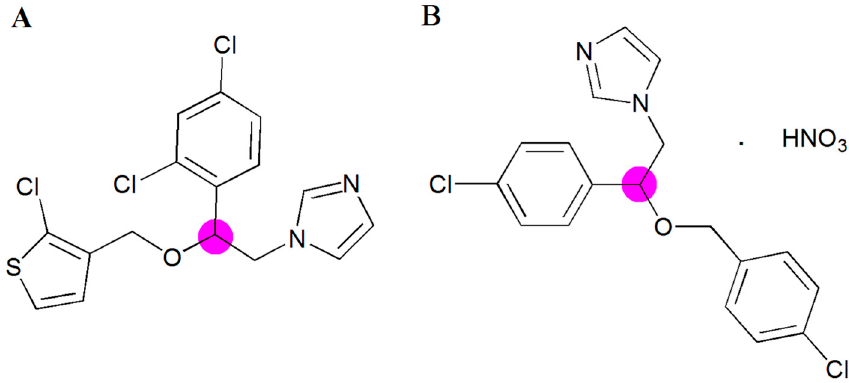
Figure 1. Chemical structure of Tioconazole ( A ) and Econazole nitrate ( B ). ● Chiral center.